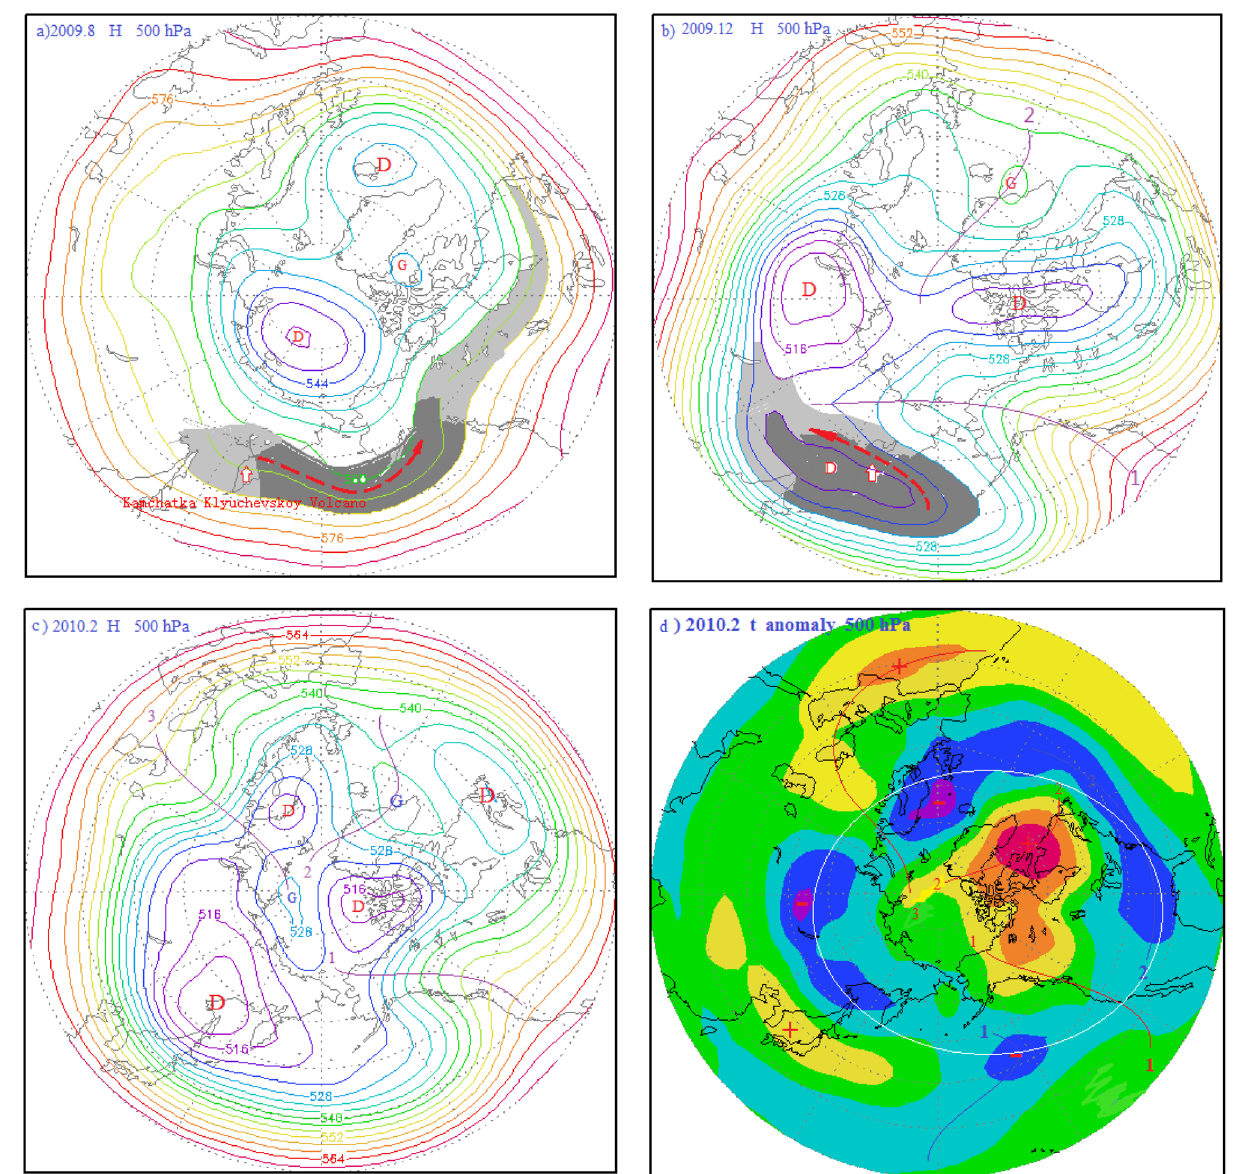
Figure 7. ( a ) 500 hPa atmospheric circulation characteristics and distribution diagram of the volcanic dust curtain and aerosol layer in the mid-high latitudes of the Northern Hemisphere in August 2009; ( b ) schematic diagram of the atmospheric circulation characteristics of the hPa layer from 40 to 90° N and distribution of the volcanic dust curtain and aerosol layer in December 2009; (° ) atmospheric circulation characteristics of the 500 hPa layer from 30 to 90° N in February 2010; ( d ) potential height field anomaly distribution of the 500 hPa from 30 to 90° N in February